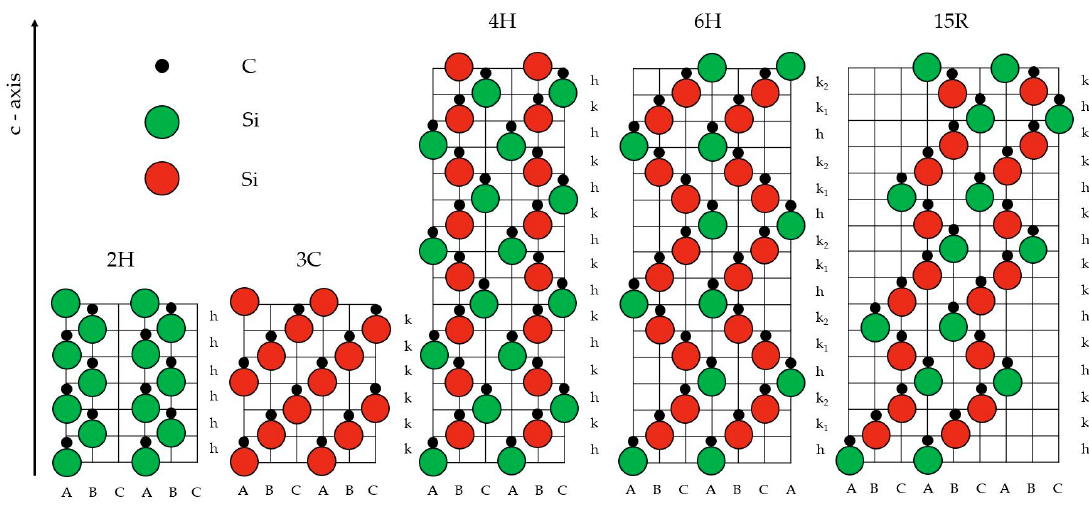
Figure 1. Diagram of the primitive cells of important polytypes of silicon carbide (SiC).